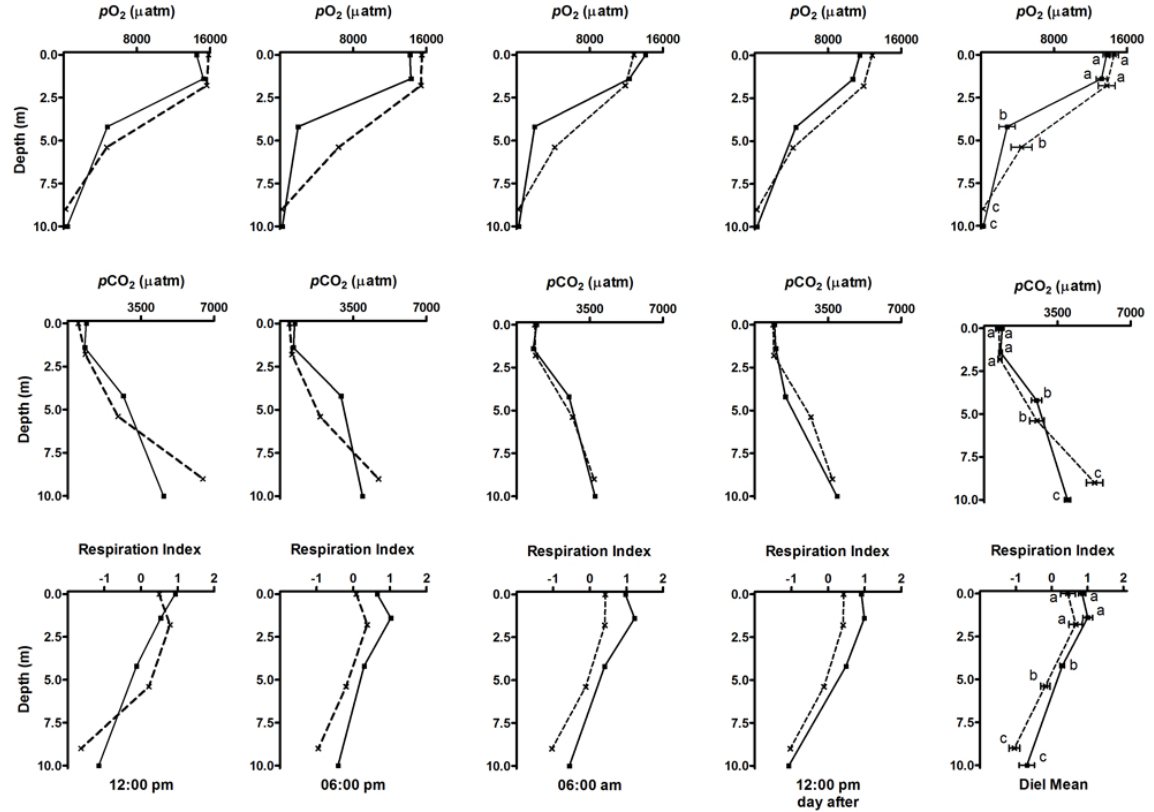
Fig. 4. Vertical profiles of daytime p O 2 , p CO 2 and respiration index from the lake surface to deep waters for Lake Barra (unbroken line, filled squares) and Lake Aguap´e (dashed line, crosses) during a thermal stratification event in the rainy season (March 2005). Values are the average ± standard error (SE). The same letters indicate non-significant differences among treatments ( p < 0.05,